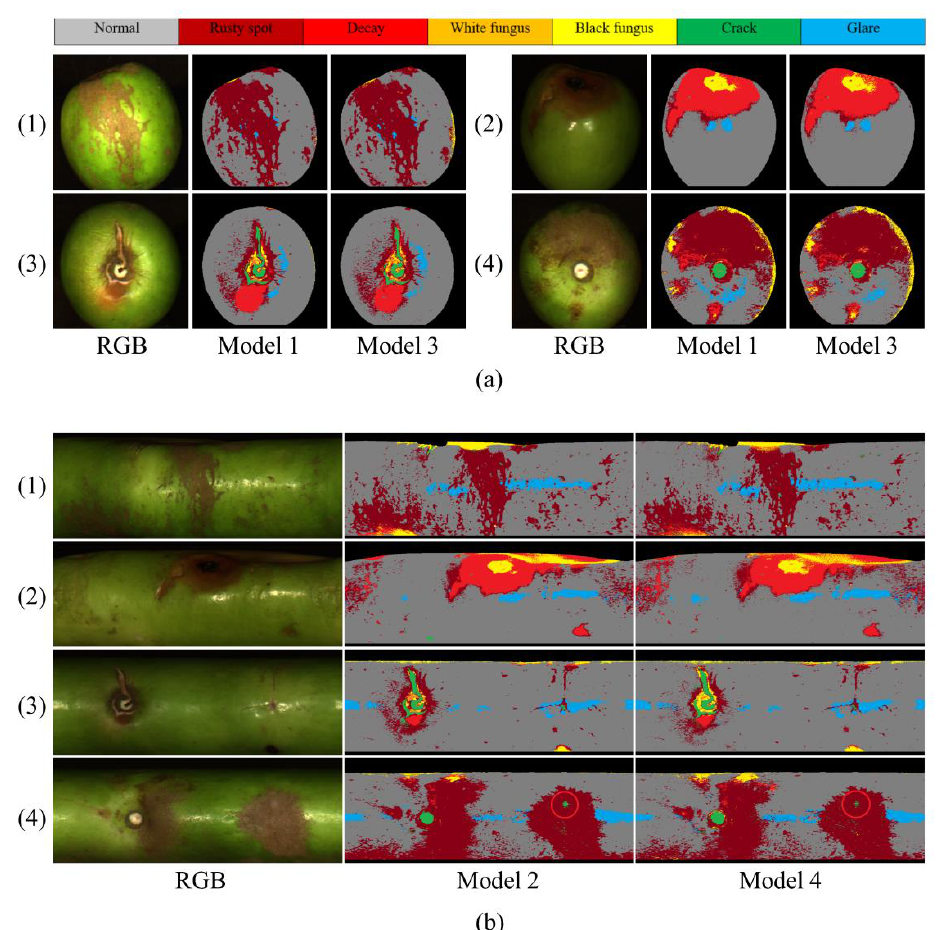
Figure 7. Classification results of jujube samples by using ( a ) linear scan and ( b ) rotation scan methods.